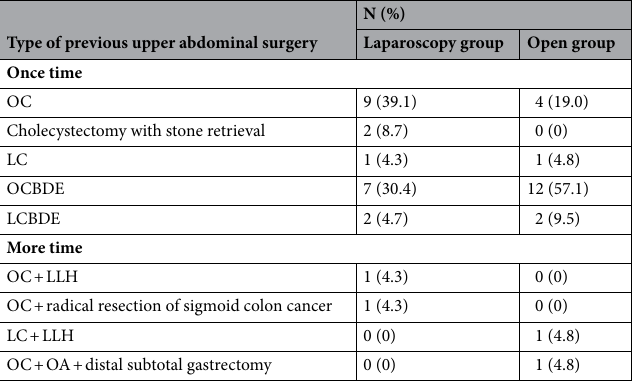
Table 1. The types of previous surgery. LC laparoscopic cholecystectomy, OC open cholecystectomy, OCBDE open common bile duct exploration, LCBDE laparoscopic common bile duct exploration, LLH left lateral sectionectomy.